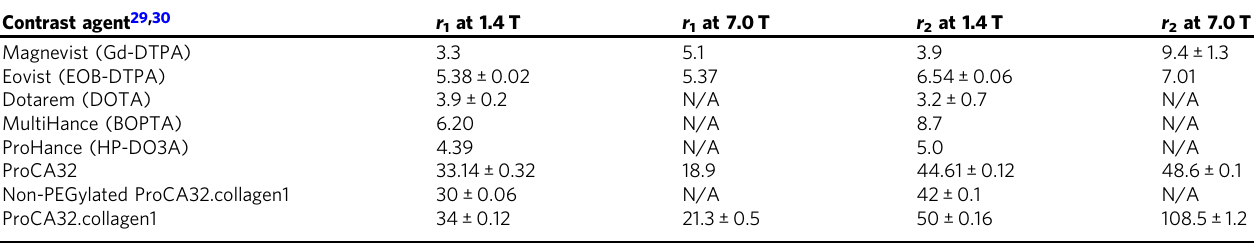
Table 1 Summary of r 1 and r 2 relaxivity of ProCA32.collagen1 and non-PEGylated ProCA32.collagen1 and their comparison with ProCA32 and clinical contrast agents at 1.4 and 7.0 T, 37 °C Contrast agent